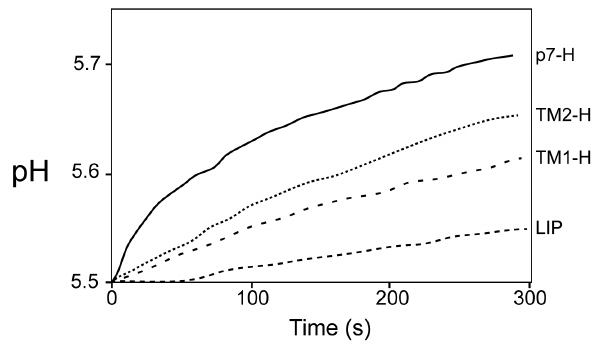
Figure 8. Proton transport of p7 and its fragments. Comparison of liposomal proton transport mediated by p7 full length, p7-TM1 fragment and p7-TM2 fragment solubilized in HFIP prior mixing with lipids (protein to lipid molar ratio 1:125); LIP, negative control without peptide.